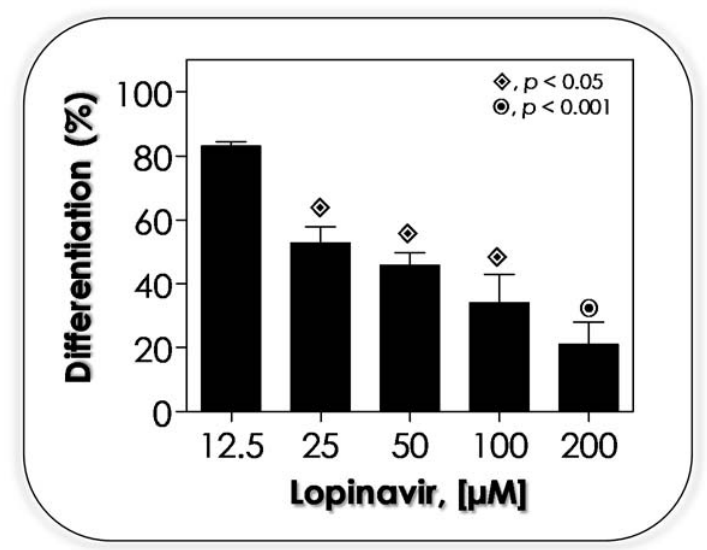
Figure 6. Effect of lopinavir on C. albicans yeast into germ tube transformation (morphogenesis process). Germination was performed by incubating the yeasts (10 6 cells) in fetal bovine serum for 4 h at 37 °C in the absence or in the presence of lopinavir at different concentrations. The number of cells presenting germ tube formation was counted in a Neubauer chamber. The values represent the mean ± standard deviation of three independent experiments performed in triplicate. The symbols indicate the experimental systems considered statistically significant from the control (Student’s t test).